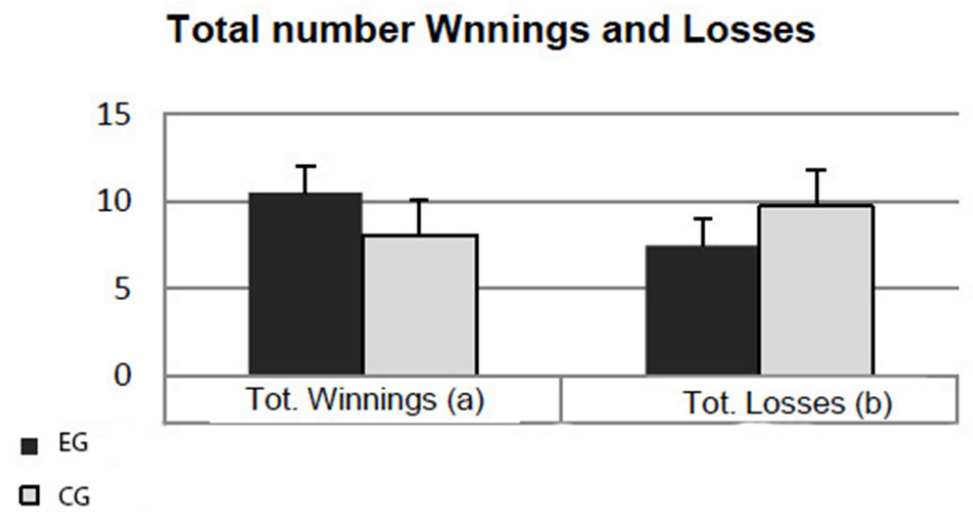
Figure 3. Results at the Game of Dice Task (GDT): effects on Total Number Winnings (panel a ) and Total Number Losses (panel b ).